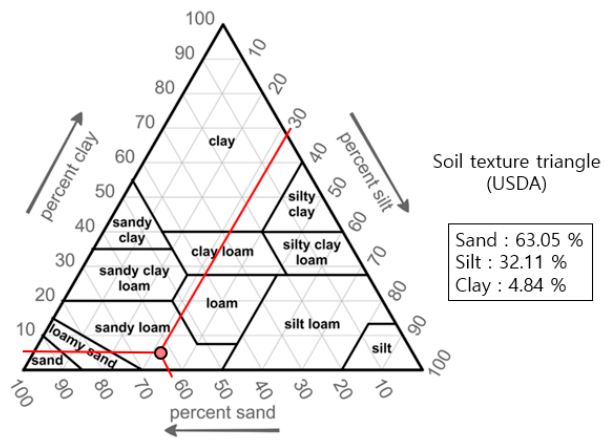
Figure 2. Soil texture triangle